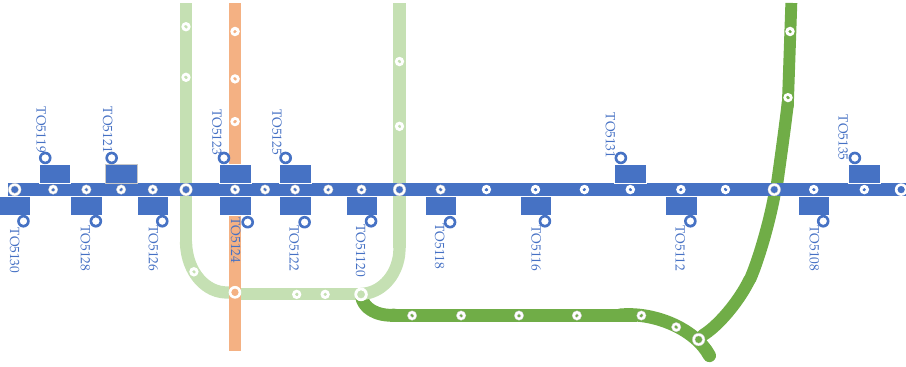
Figure 1. The interface of train simulation results.